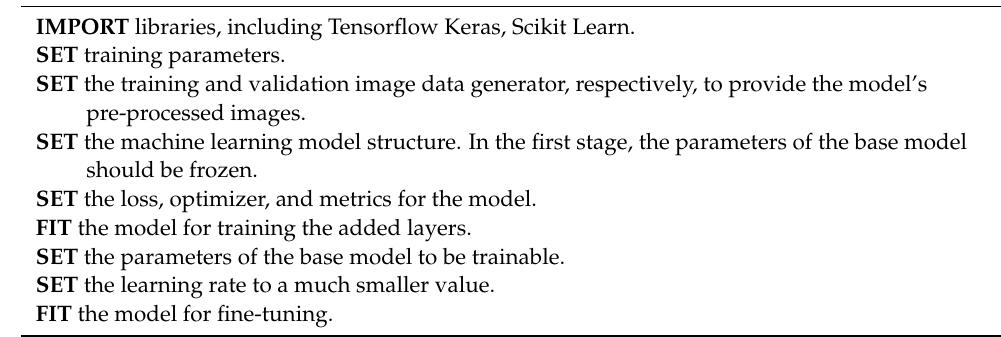
Algorithm 1 Pseudo Code of the Model Training Process